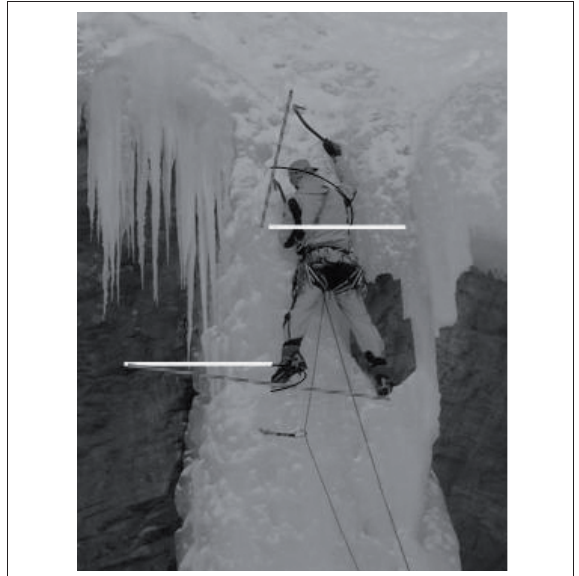
Figure 1. Angle between horizontal position, the left and the right